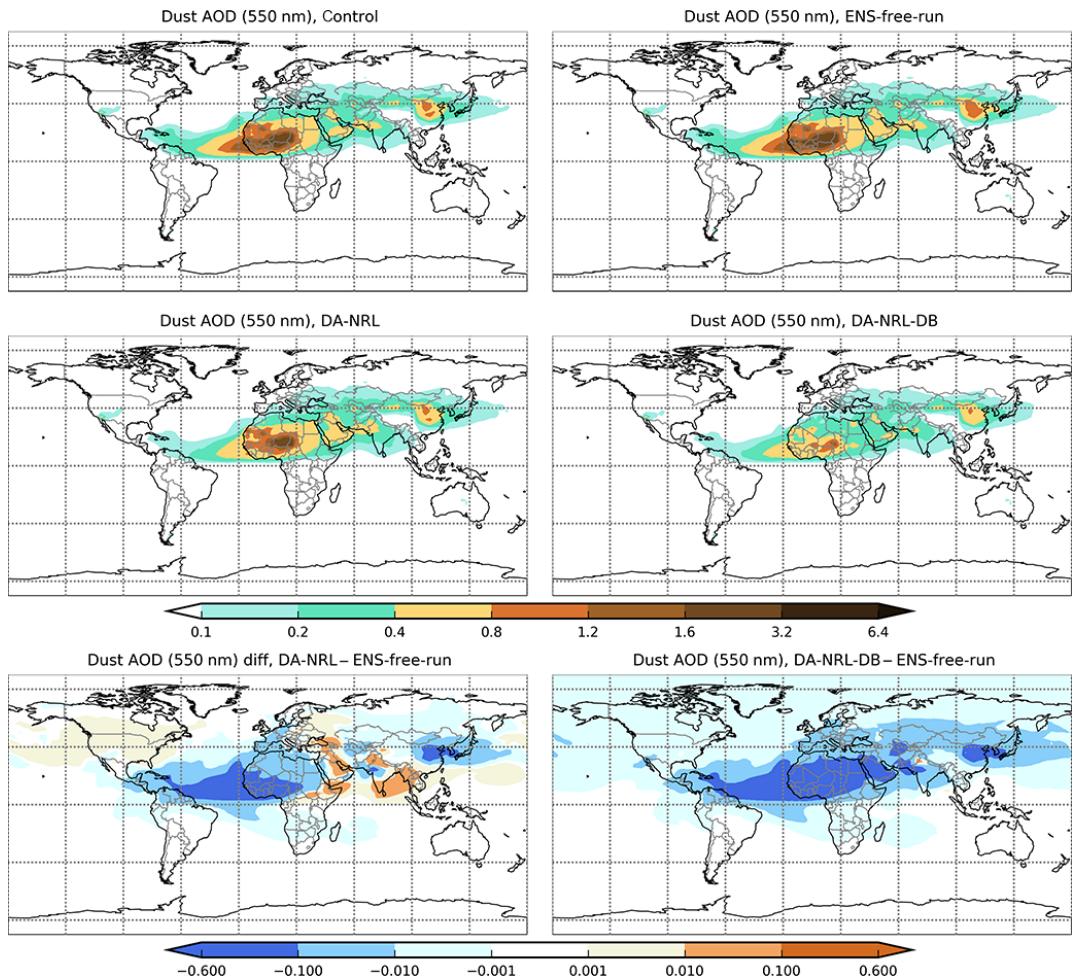
Figure 6. Dust optical depth averaged for the month of May 2007 for the Control (top left), ENS-free-run (top right), DA-NRL (centre left), and DA-NRL-DB (centre right) experiments, and dust optical depth difference between the DA-NRL (bottom left), DA-NRL-DB (bottom right), and ENS-free-run